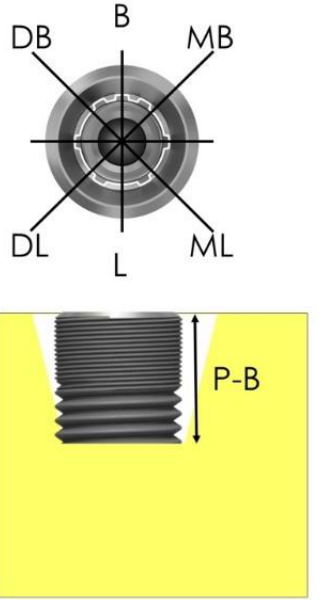
Figure 3. Bone defects were assessed at six defined points from implant shoulder to the most coronal 163 position of the bone. 164